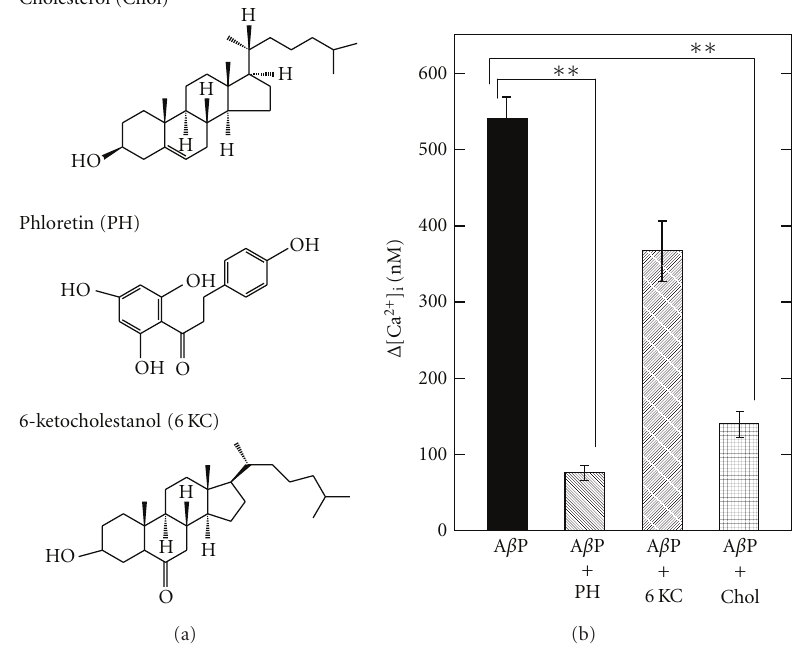
Figure 6: E ff ect of membrane charges and fluidity on A β P-induced [Ca 2+ ] i rise. The solutions of phloretin (PH), 6-ketocholestanol (KC), and cholesterol (Chol) were preadministrated on GT1-7 cells; and A β P-induced [Ca 2+ ] i rise was analyzed. Data are mean ± S.E.M., n = 250, ∗∗ P < . 001. (modified from